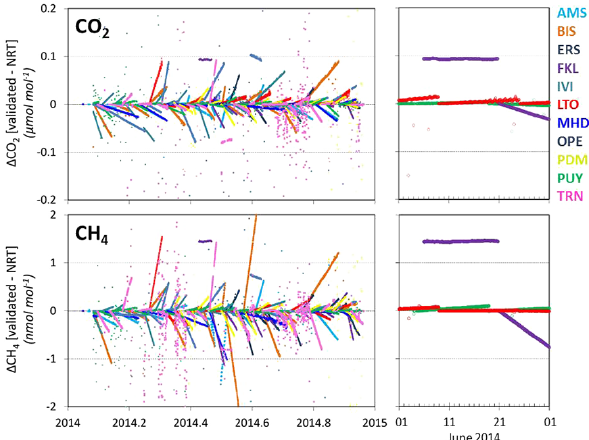
Figure 10. CO 2 (above) and CH 4 (below) mole fraction differences between the validated and the near-real-time values at 11 stations in 2014 (left), and at three stations (Finokalia – FKL; Lamto – LTO; Puy de Dôme – PUY) in June 2014 (right). Most of the differences correspond to the drift between two calibrations, which cannot be considered in real time. Each point corresponds to an hourly aver-